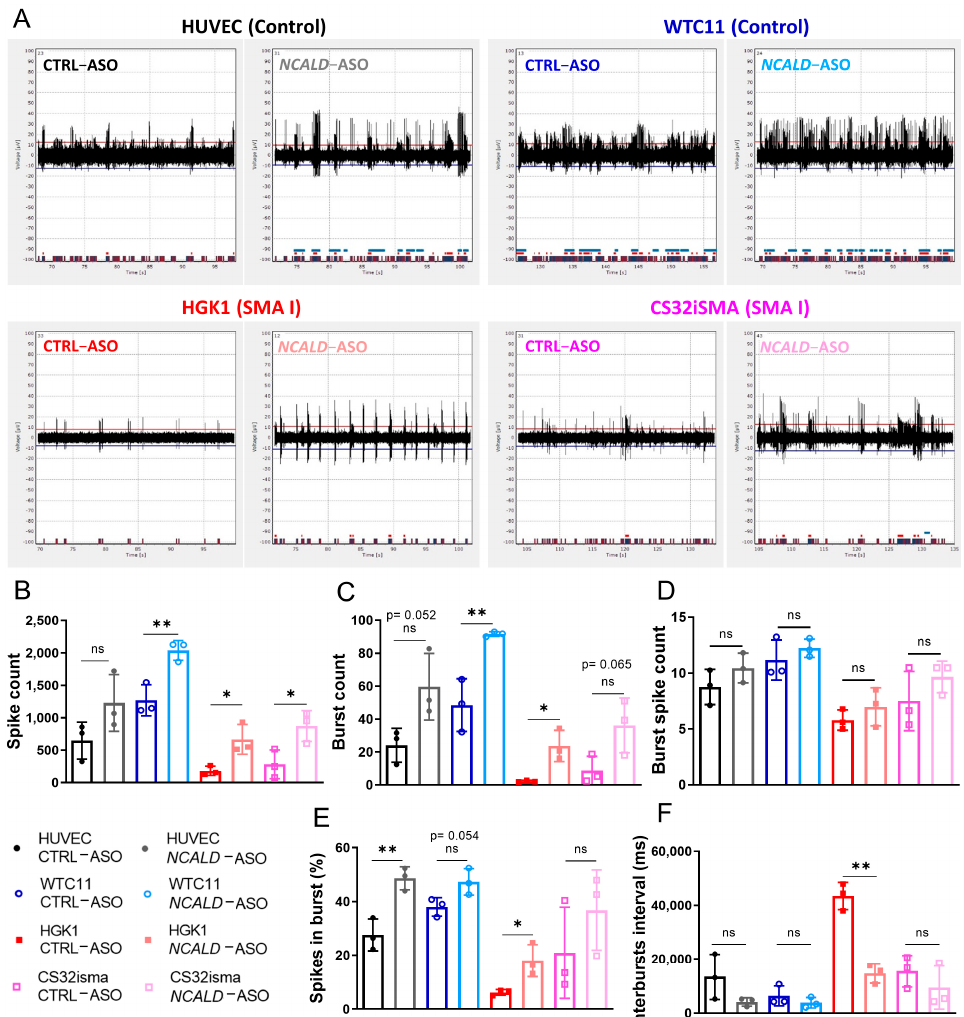
Figure 5. Multielectrode array shows increase in neuronal firing upon NCALD − ASO69 treatment. ( A ) Representative images of the activity detected by one electrode for 30 s per condition. ( B – F ) MEA analysis of various parameters ( B ) spike count, ( C ) burst count, ( D ) burst spike count, ( E ) spikes in burst and ( F ) interbursts interval measured at day 20 of CTRL-ASO or NCALD -ASO69-treated MNs. Dots in the graphs represent the average values of the technical replicates of each independent experiment, in total, three independent experiments corresponding to three independent MN differentiations (N = 3, n = 3–4). Unpaired two-tailed Student’s t test was performed in each line to compare CTRL-ASO versus NCALD -ASO treatment. All values reported as mean and error bars represent ± SD. * p ≤ 0.05, ** p ≤ 0.01. ns = not